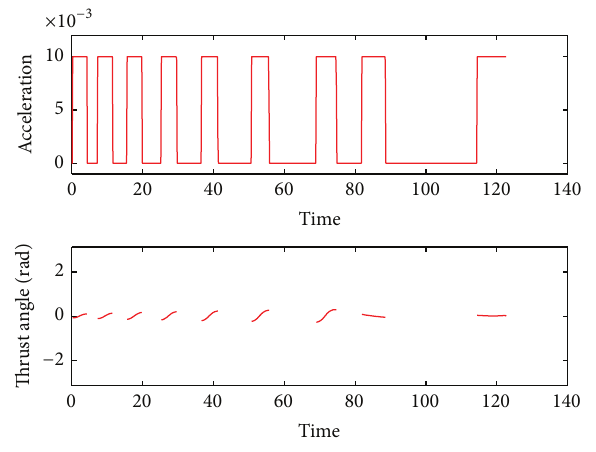
Figure 17: Time history of control